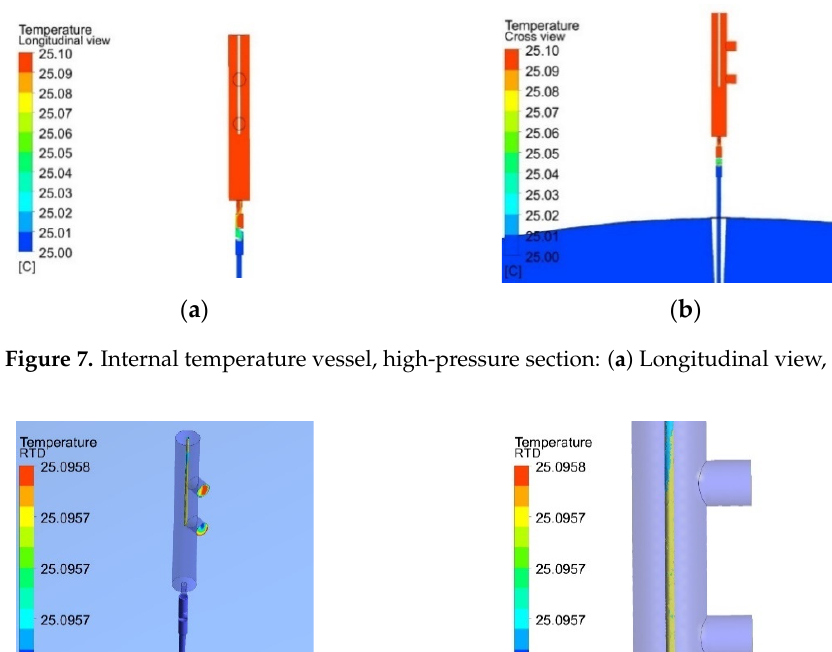
Figure 8. RTD temperature, high-pressure section: ( a ) Isometric view, ( b ) Longitudinal view (zoom).